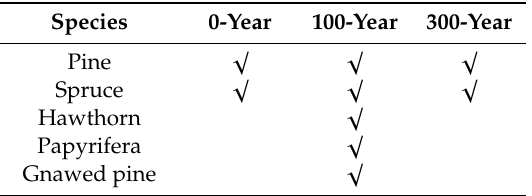
Table 2. The samples of timber